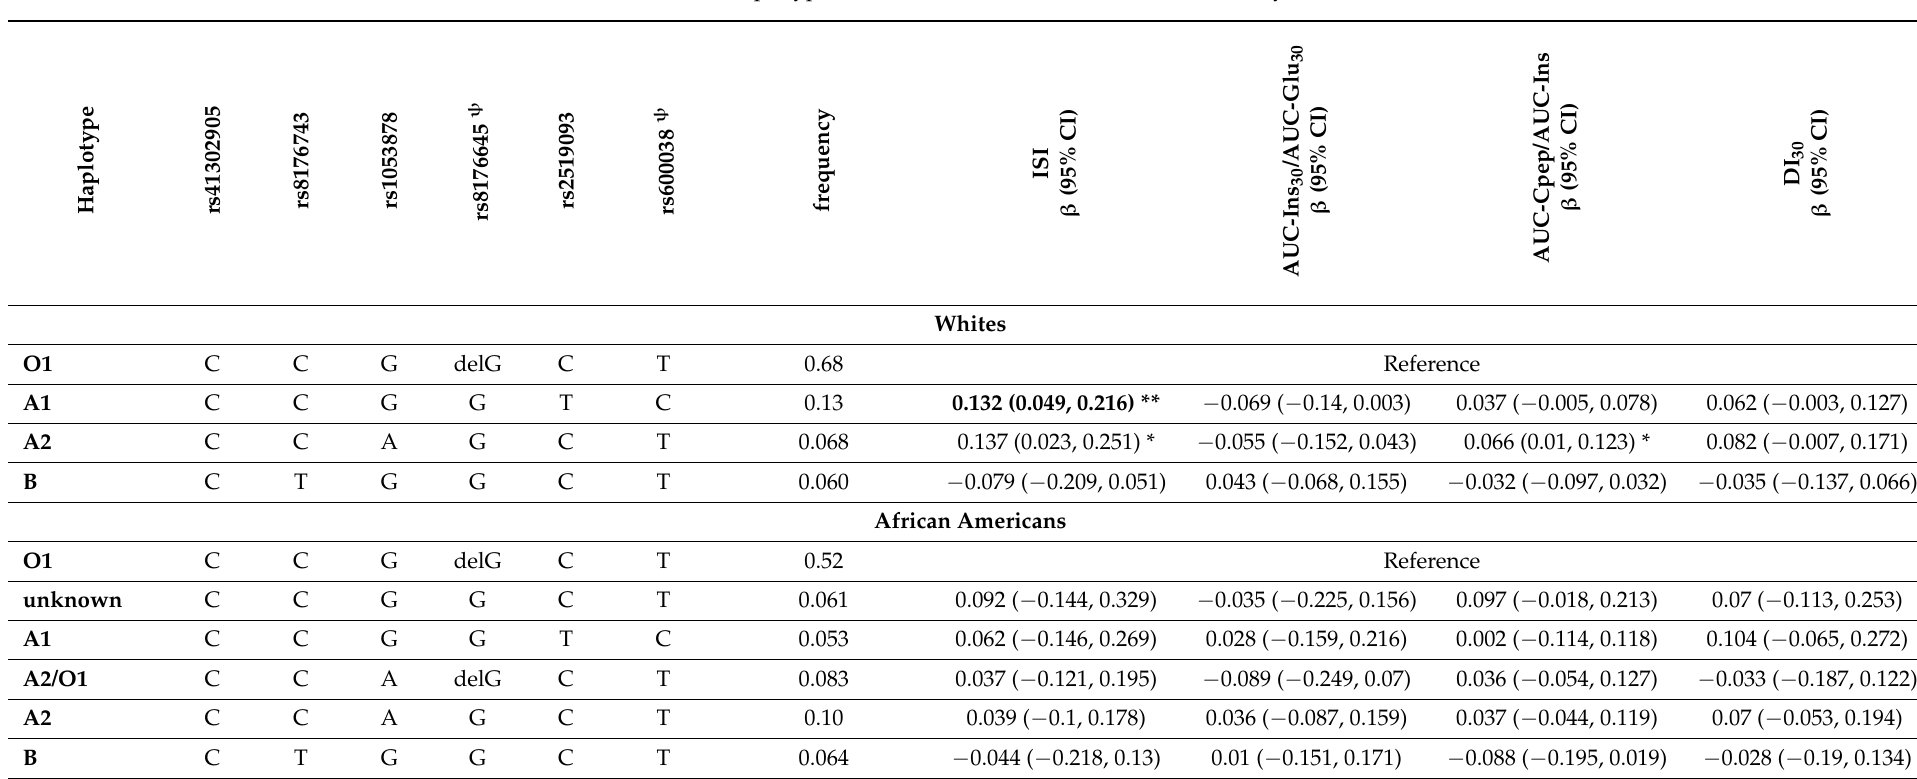
Table 2. The associations between ABO haplotypes and insulin related traits in the MILES